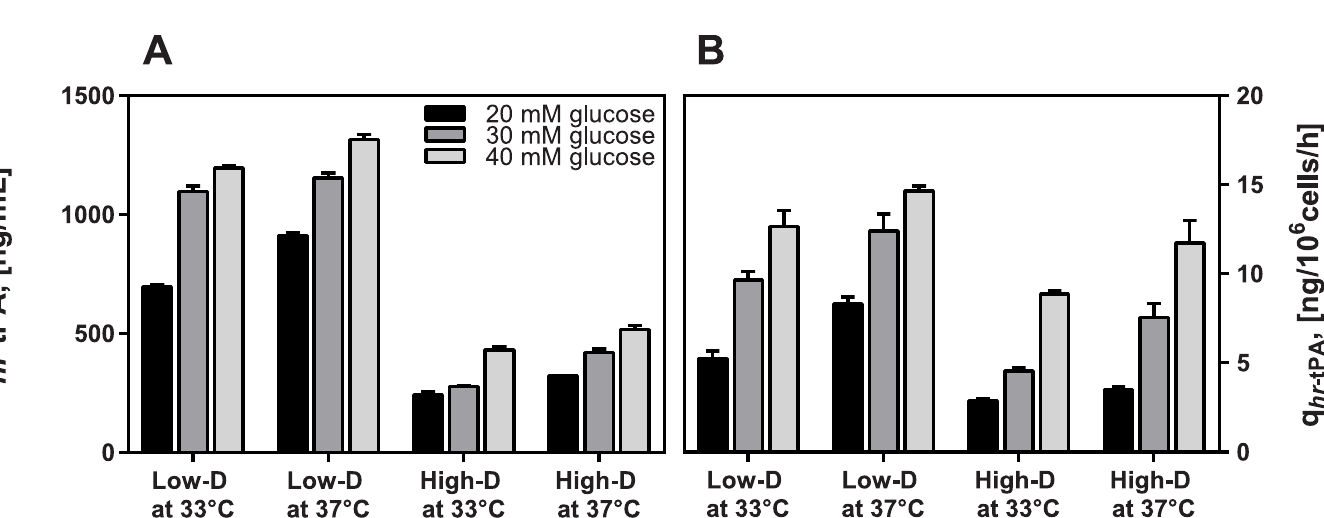
Fig 2. Impact of dilution rate, culture temperature and feed glucose concentration on hr -tPA production and specific hr -tPA productivity in CHO cell chemostat cultures at steady state. ( Black ) 20 mM glucose; ( Dark grey ) 30 mM glucose; ( Light grey ) 40 mM glucose.